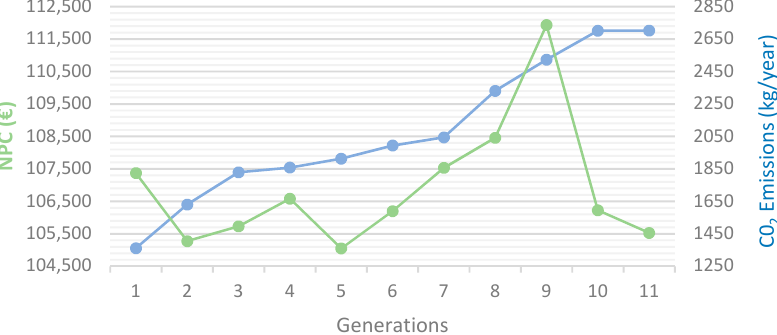
Figure 5. Results for NPC and CO 2 emissions for every generation.